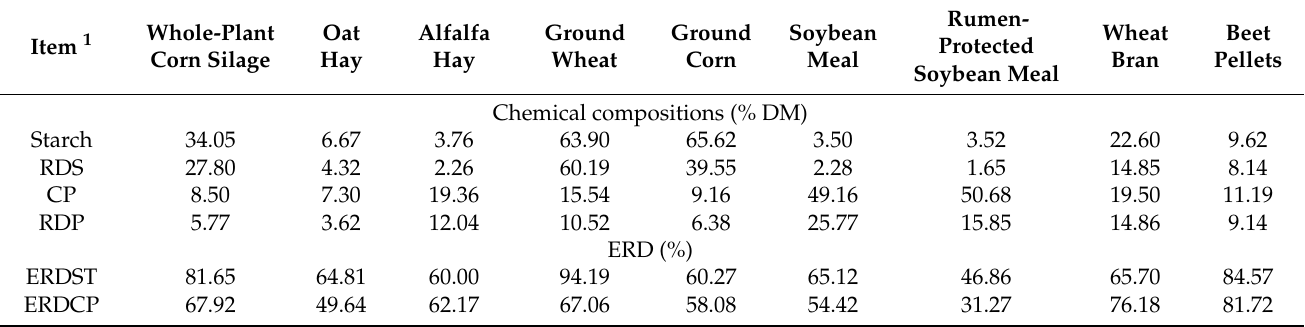
Table 2. Effective ruminal degradability and content for starch and crude protein (CP) of principal dietary